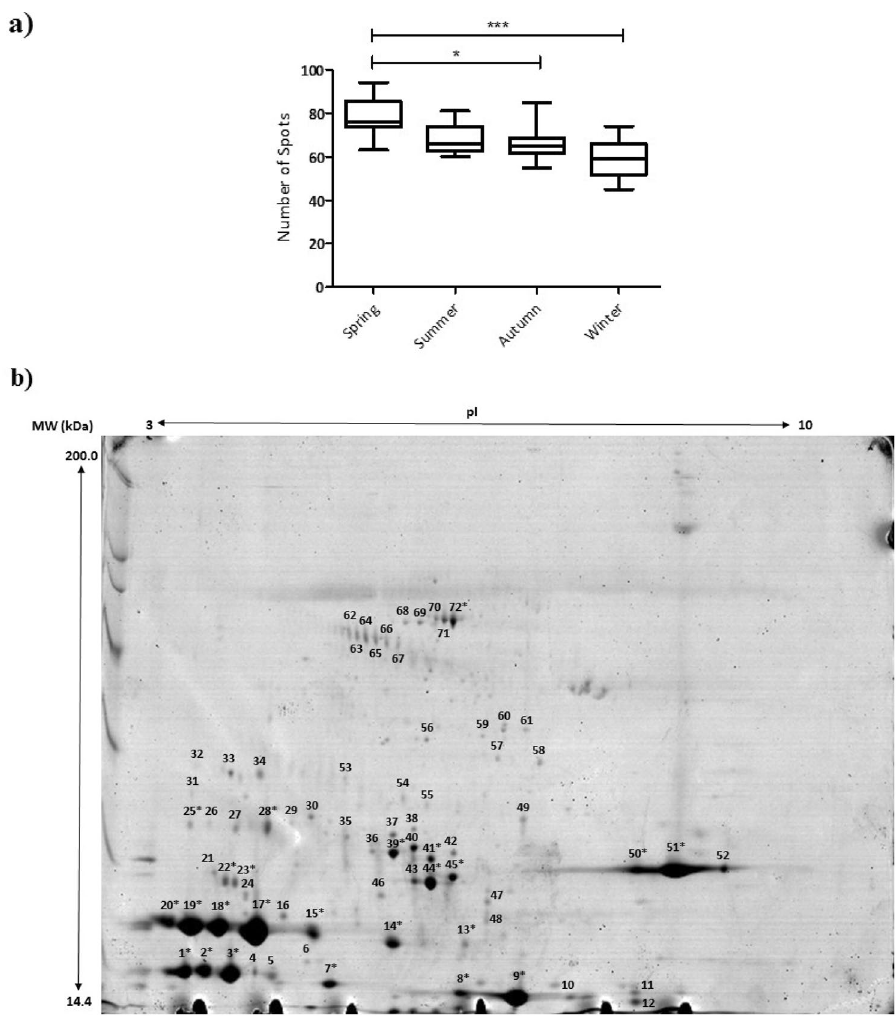
Figure 3. Spots representing proteins from the seminal plasma of stallions in climatological seasons. ( a ) Boxplot of the total number of spots detected by climatological season in gels from the analysis by two- dimensional electrophoresis (2-DE) of the seminal plasma. Three stallions were assessed for different seasons over 1 year, in three replicates. Significant differences in the averages of the number of protein spots by the Tukey test ( p < 0.05) between spring and autumn gels (*) and spring and winter gels (***) were detected. ( b ) Two-dimensional reference gel for assessment of the protein profile in the seminal plasma of Mangalarga Marchador stallions. The gel contains the 72 spots, on average detected in the seminal plasma. This gel, corresponding to Stallion 1 in the spring season, was used as a reference gel since this treatment showed all the analysed spots among the 2-DE gels in Fig. 2. The proteins were separated using pH 3–10 immobilised pH gradient (IPG) strips (24-cm, linear) and 12.5% T SDS-PAGE gels. Broad-Range Molecular Marker (Bio-Rad) was used (14.4–200 kDa). pI, isoelectric point. MW, molecular